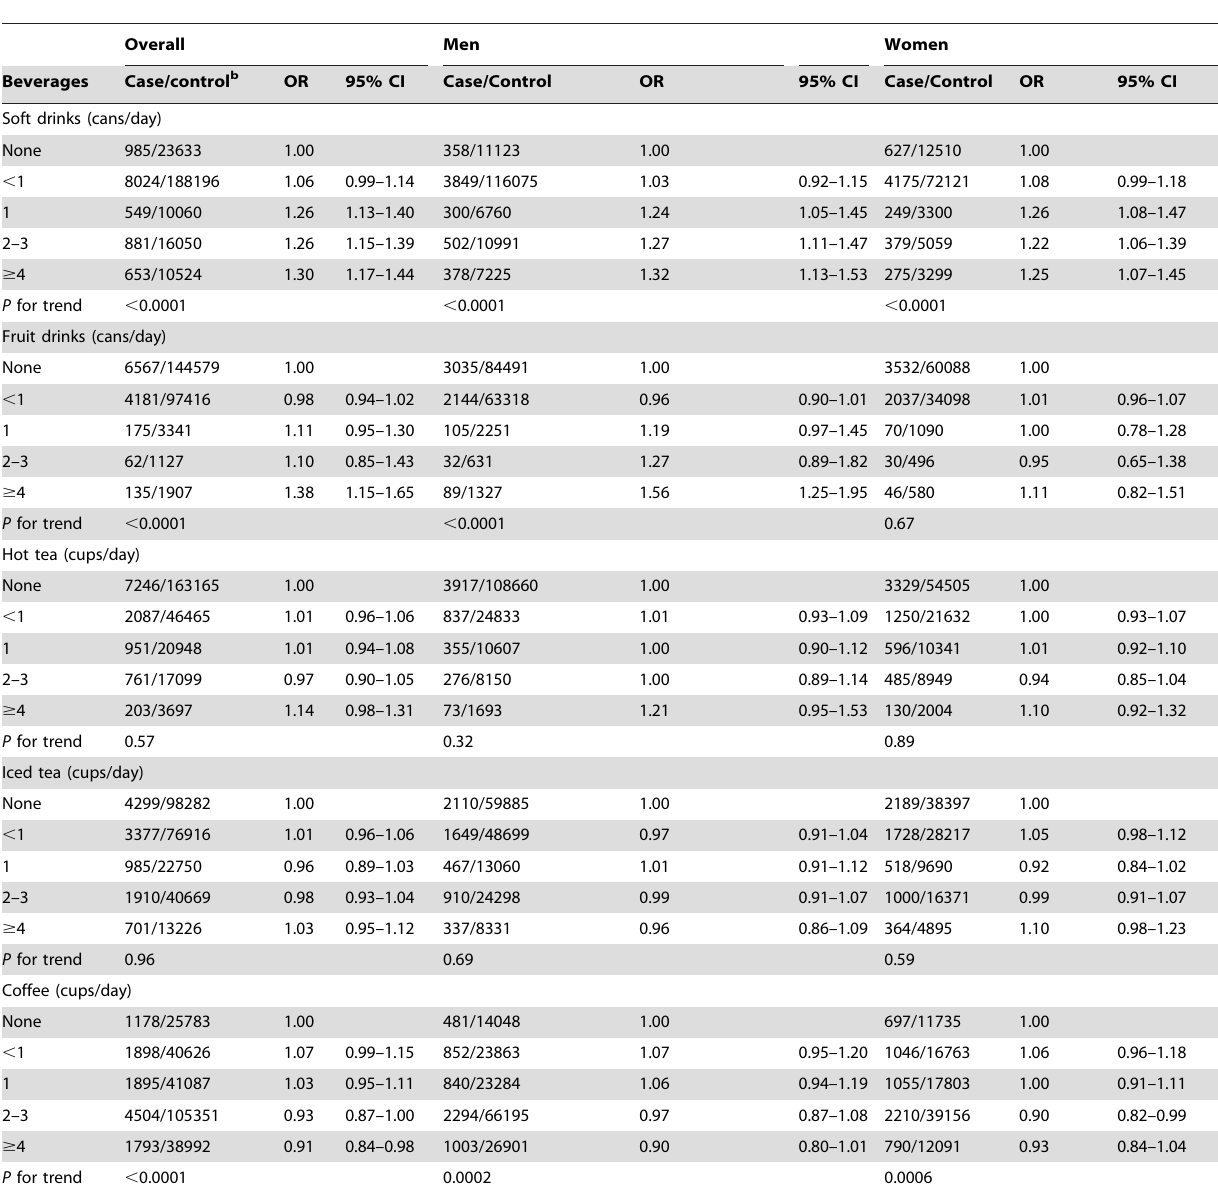
Table 2. Odds ratios a and 95% confidence intervals of depression according to baseline beverage consumption in the NIH-AARP Diet and Health Study,